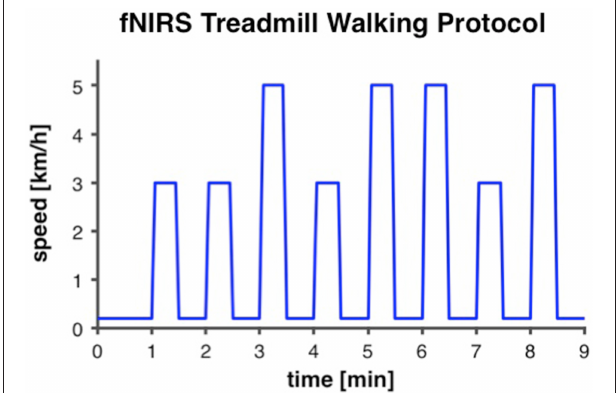
FIGURE 2 | Intermittent fNIRS treadmill walking protocol. The protocol was repeated two times with 3 min recovery in between. It started with 1 min of very slow walking at 0.2 km/h for the measurement of baseline fNIRS-values. Thereafter, eight intervals of 30 s at either preferred or fast individual walking speed (3 and 5 km/h, respectively, in this example), with 30 s of rest at 0.2 km/h, were performed.